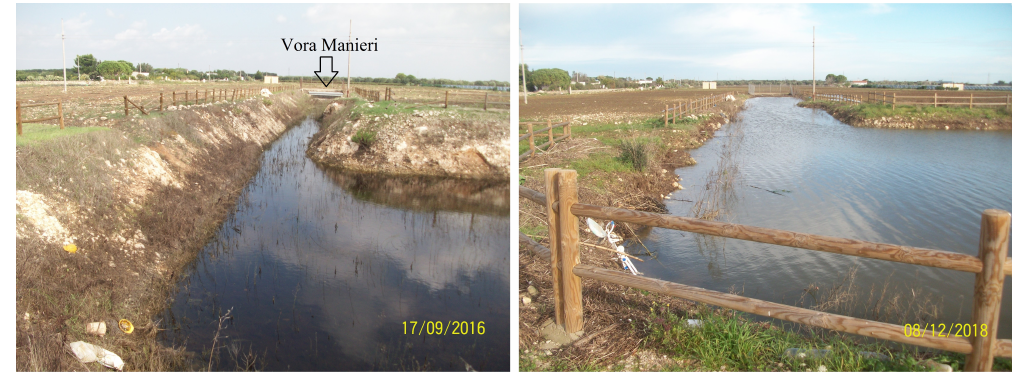
Figure 3. Hydrometric level of the final course of the new channel of the Asso Torrent; left: low after the first rains of the beginning of the 2016 wet season; right: high at the onset of a flood, resulting from moderate precipitation before 8 December 2018.